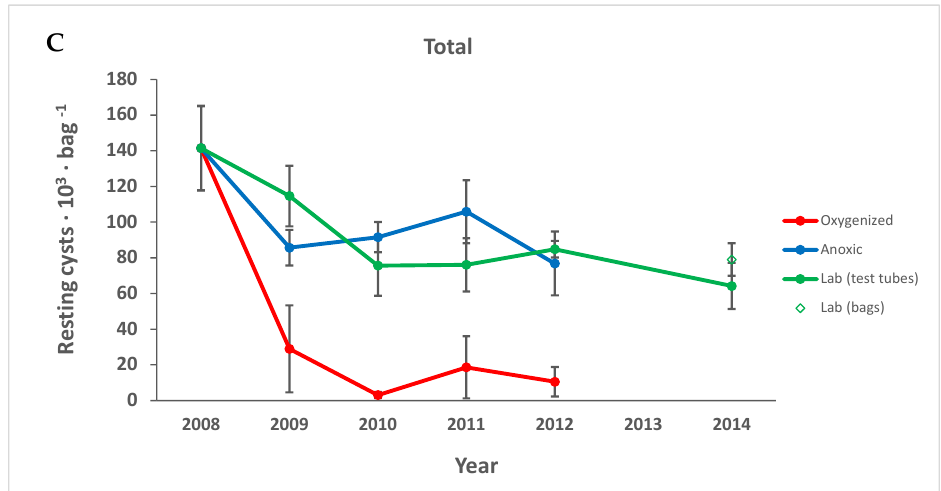
Figure 3. Cysts presumed to be alive, with live-like contents ( A ) decreased in all treatments, while the number of dead and empty cysts ( B ) decreased only in the oxygenated environment. The total number of cysts is shown in ( C ). Points are averages and error bars show the standard error of the mean.